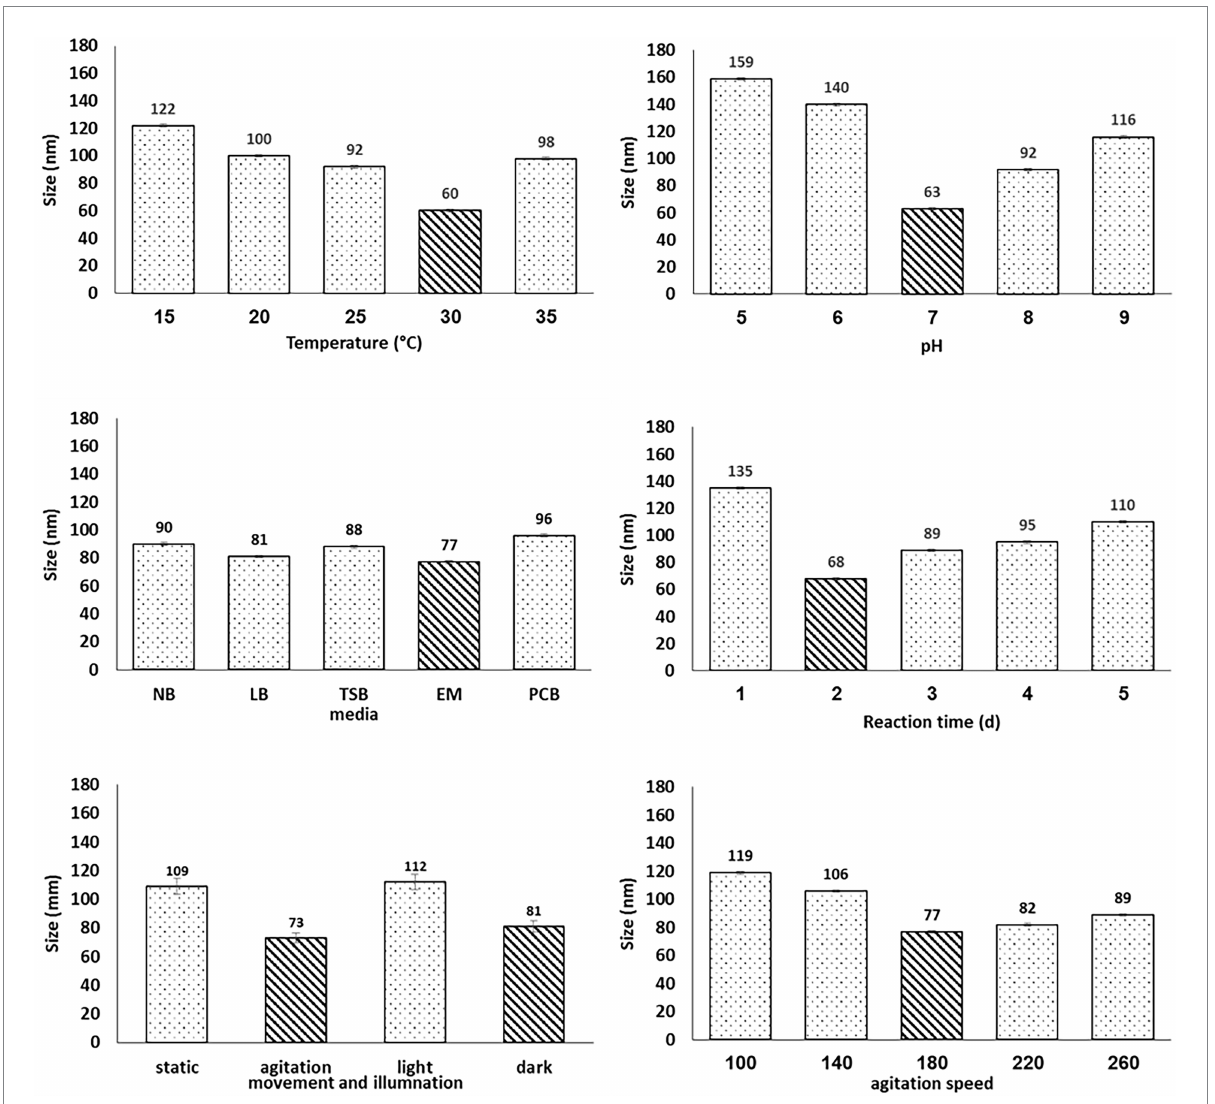
FIGURE 1 Optimization of the physiochemical parameters for fabricating by Bacillus subtilis AS12. Data are presented as means ±